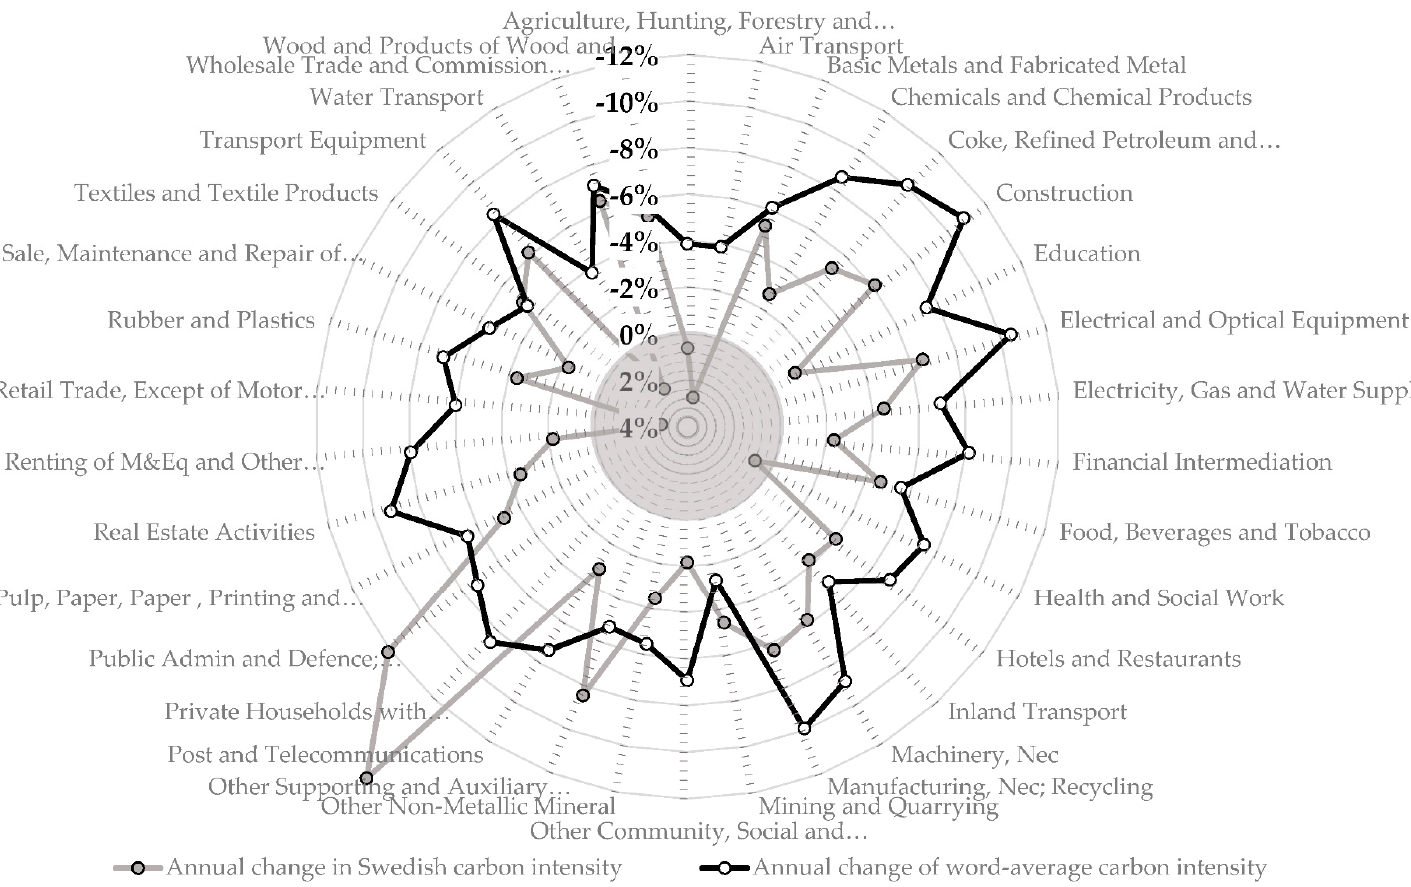
Figure 6. Average annual rate (%) of change (compound annual growth rate) in sectoral carbon intensity (tons of CO 2 / $exports) in Sweden and the world average. Note: grey shaded circle indicates sectors that experienced an increase in carbon intensity throughout the period 1995–2009. All of these 5 sectors are productive sectors of the Swedish economy.